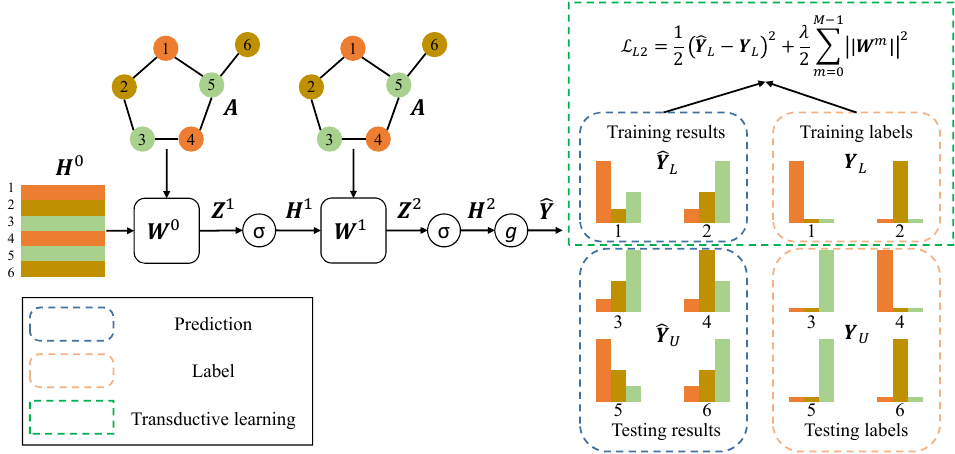
Figure 2. The pipeline of the graph transductive learning on semi-supervised node classification tasks. Algorithm 1: Approximate fractional order